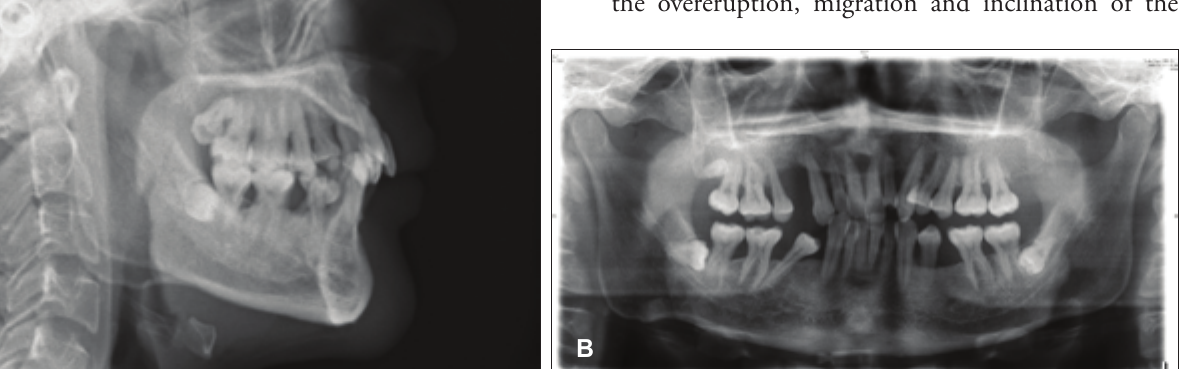
Figure 3. Pretreatment lateral cephalogram, panoramic radiograph of a 32-year-old periodontally compromised patient with deep